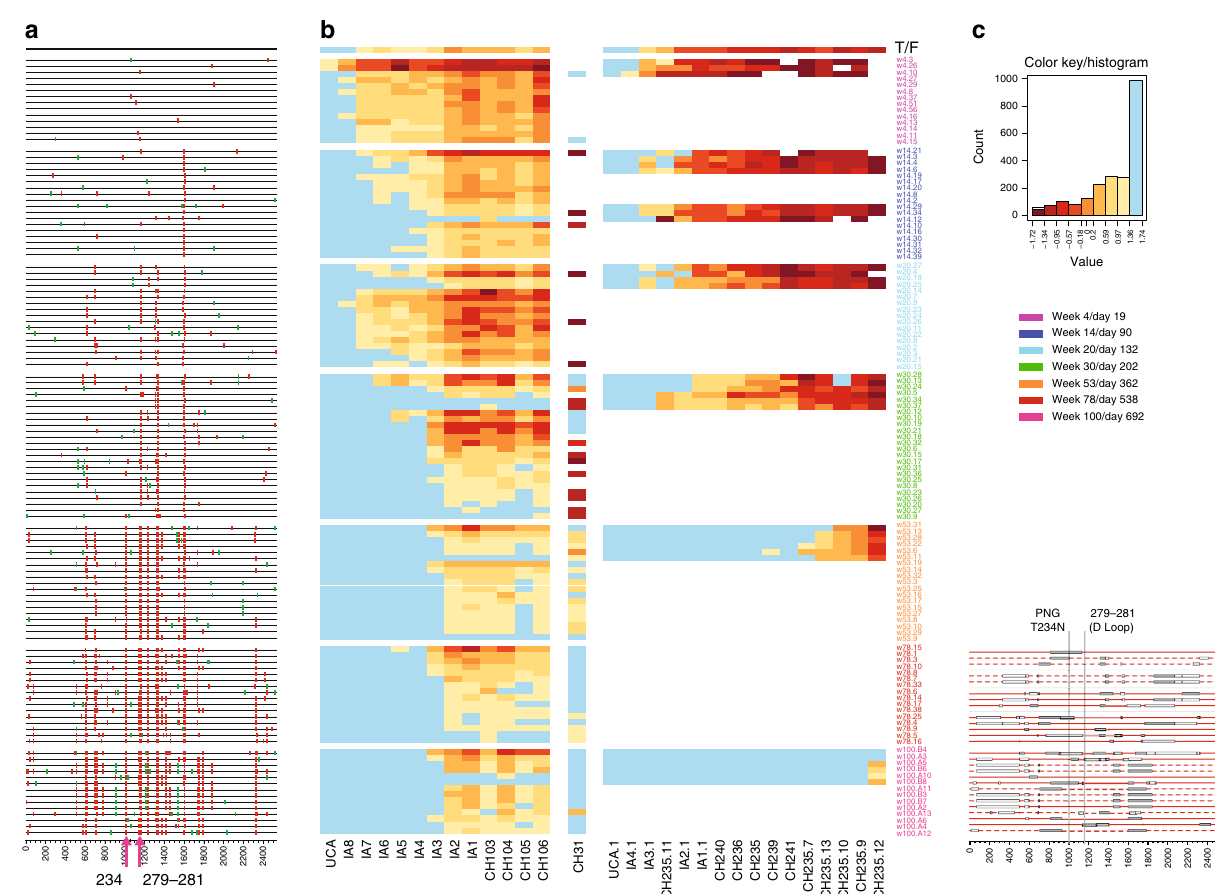
Fig. 8 Sequence and neutralization analysis of viruses from homogeneously infected CH0505. a Syn/nonsyn highlighter plot shows the synonymous (green) and nonsynonymous (red) mutations compared to the T/F sequences. b Autologous neutralization analysis. Multiple Env pseudoviruses were generated from seven time points from CH0505 over 2 years of infection. Neutralization susceptibility of 123 pseudoviruses were determined with 13 CH103-lineage antibodies (right panel) and neutralization susceptibility of 33 pseudoviruses were determined were determined with 16 CH235-lineage antibodies (right panel). Neutralization magnitude is color coded by warm colors, with red being the strongest. Blue color indicates that no neutralization activities were detected with neutralizing antibodies at the 50 µ g/ml concentration. c Recombinant env genes from days 538 and 692 after infection. Recombinants and their breakpoints, as determined by RAPR, are shown. Recombination breakpoints are shown as black boxes, and they are fi lled when the breakpoints are signi fi